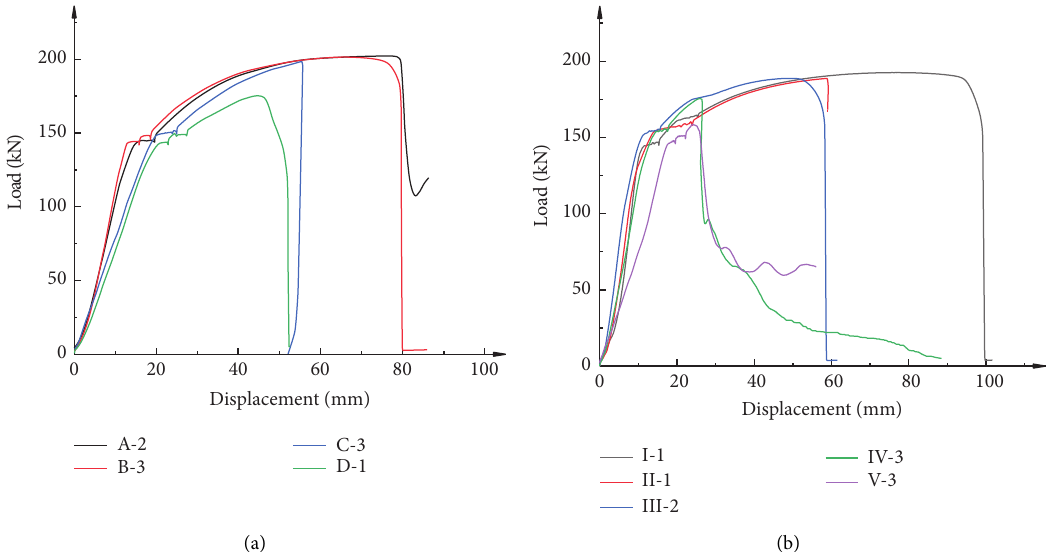
Figure 7: Displacement-load curve. (a) Different grout’s strength. (b) Different grouting fullness.